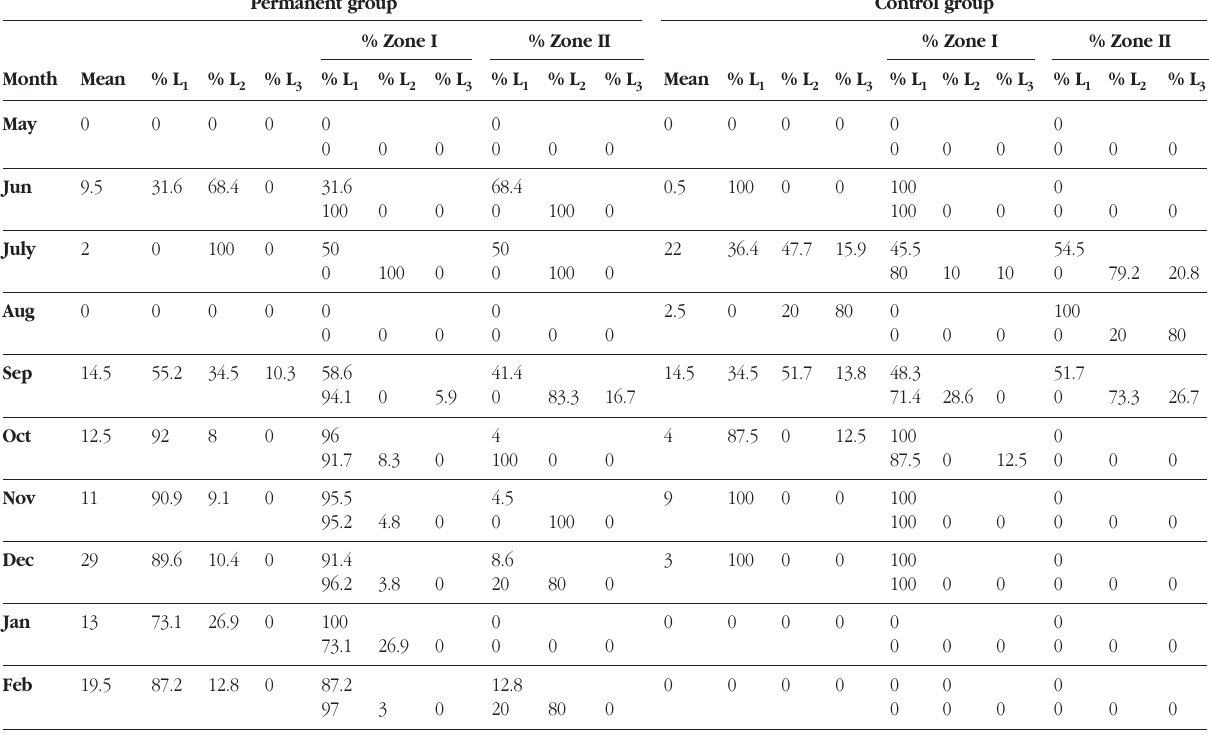
Table I. – Monthly Oestrus ovis larvae of permanent and control